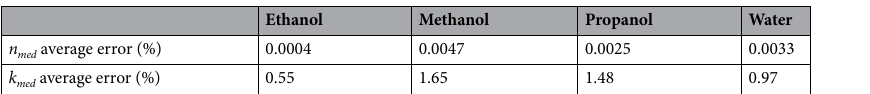
Table 2. The average error in the detected medium refractive index both real n and imaginary k for different sensing media.